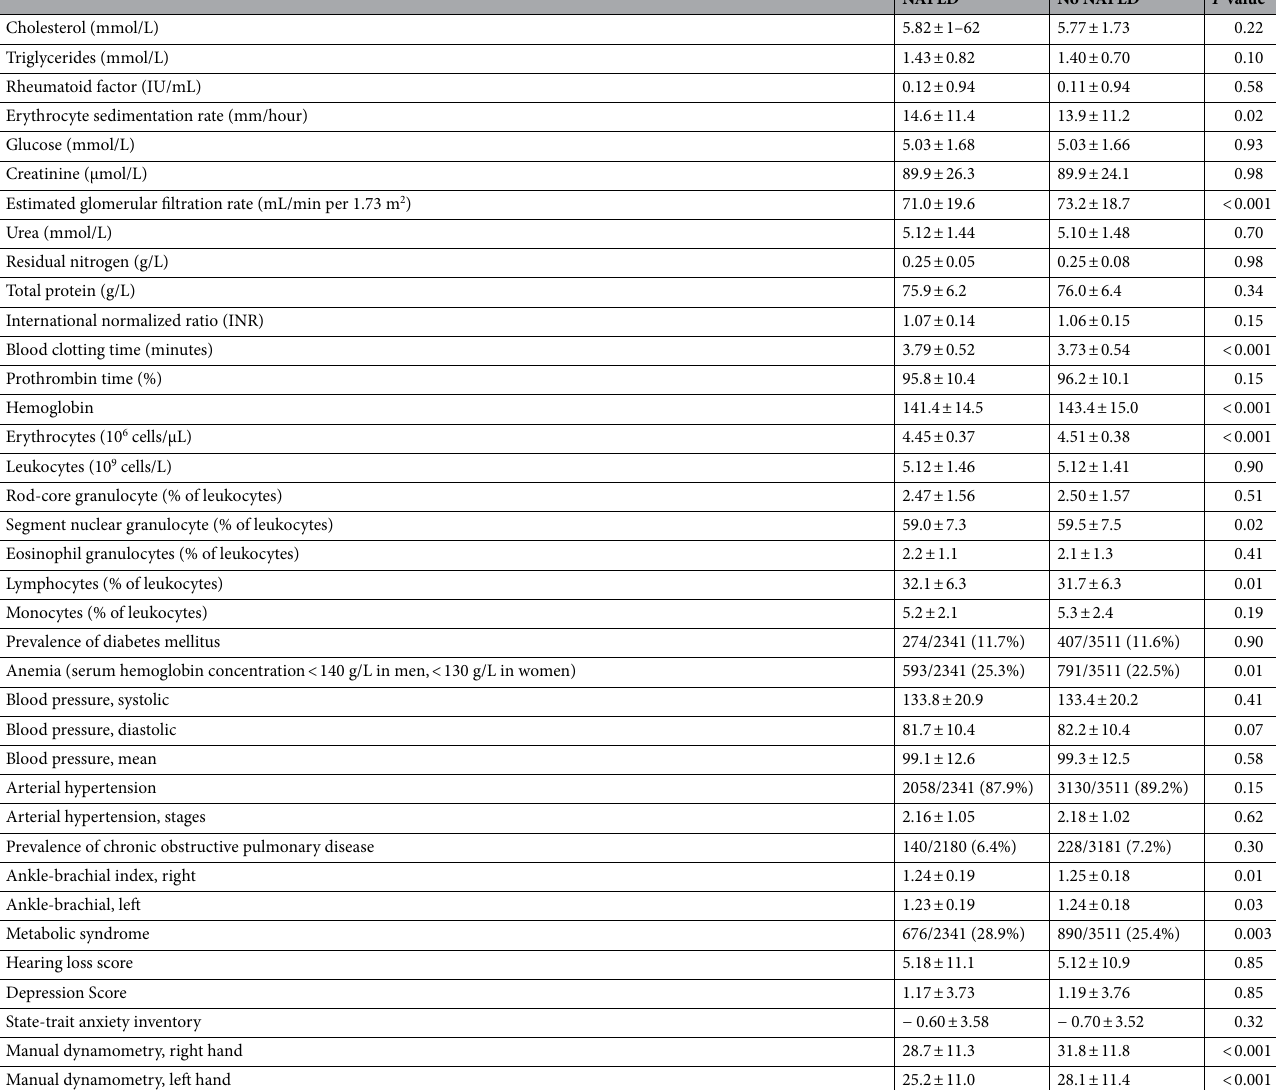
Table 1. Associations (univariate analysis) between the prevalence of non-alcoholic fatty liver disease (NAFLD) and other parameters in the Ural Eye and Medical